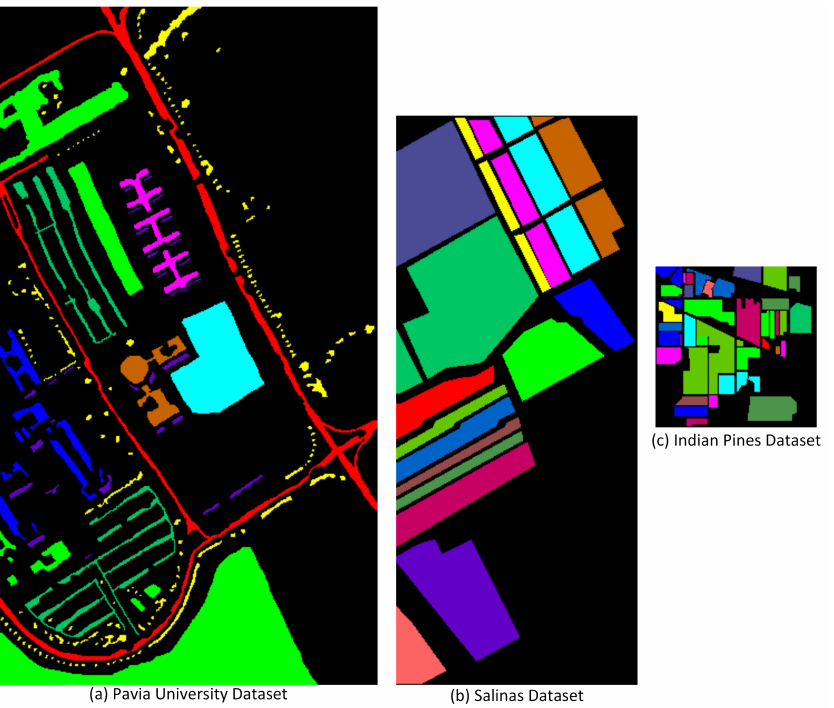
Figure 1. Ground truth of